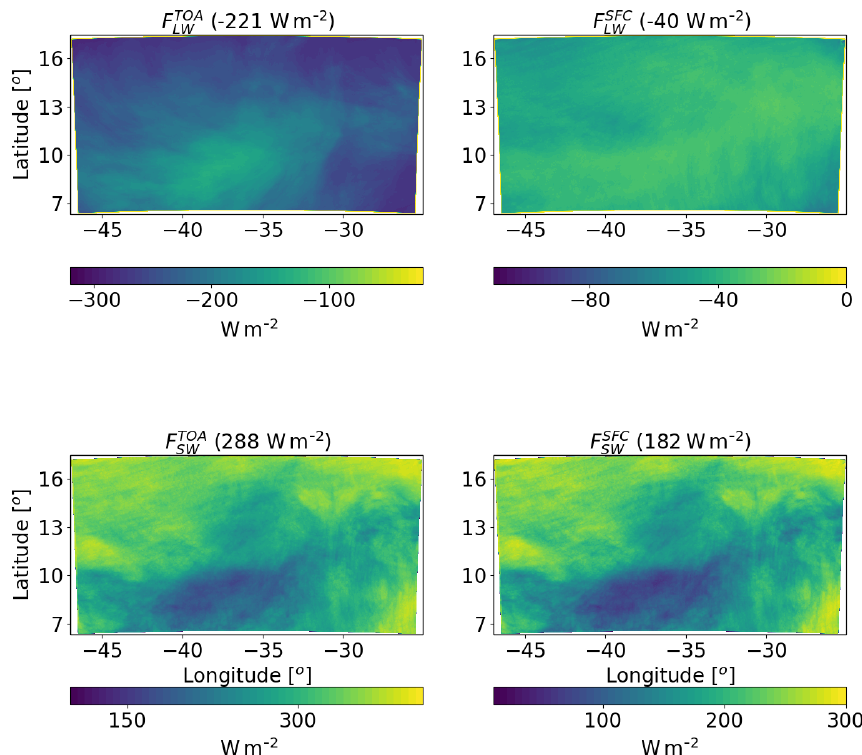
Figure 13. Spatial distribution of ICON-simulated time-mean longwave (LW) and shortwave (SW) radiation fluxes at the top of atmosphere (TOA) and surface (SFC) for a simulation of the deep-cloud-dominated case (16–18 August 2016) with CDNC = 20cm − 3 . The domain- and time-mean value of each term appear in